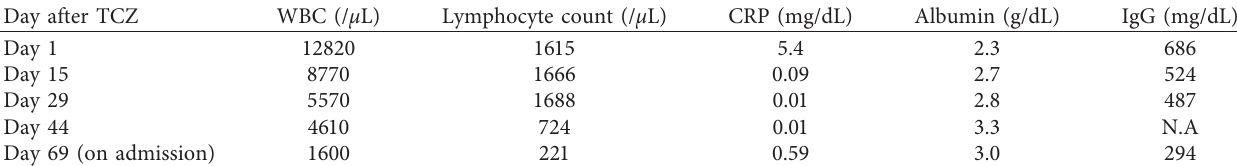
Table 1: Laboratory tests before admission.